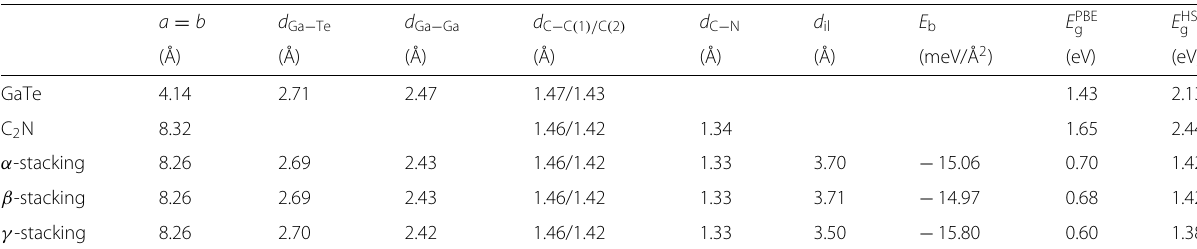
Table 1 The calculated ground-state properties of the monolayers and their heterostructures: lattice parameters of primitive unit cell a and b , bond lengths, interlayer distances ( d il ), interlayer binding energy E b (per unit area), and bandgaps calculated within